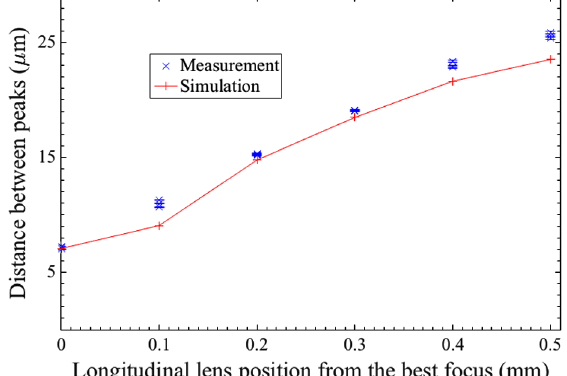
FIG. 11. Distance between OTR PSF peaks as a function of the longitudinal position of the lens ( γ ¼ 2500 ; λ ¼ 550 nm).